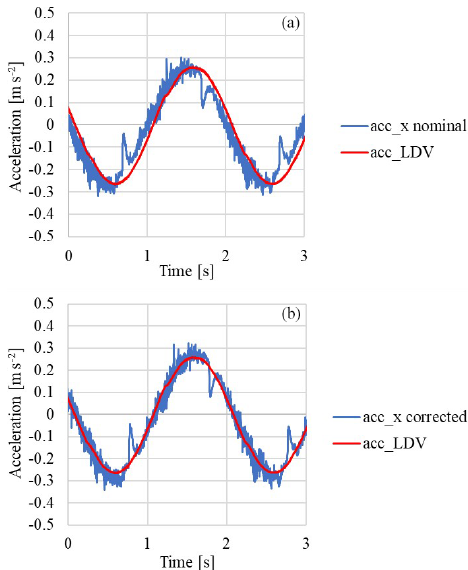
Figure 12. Comparison between the reference acceleration from the LDV (acc_LDV), and the acceleration from the IEPE ac- celerometer (a) using the nominal sensitivity (acc_x nominal) and (b) corrected in phase and amplitude by means of the calibration (acc_x